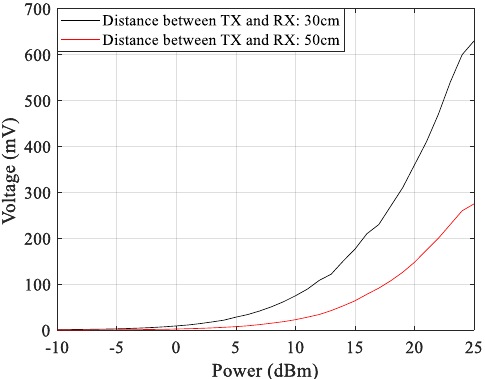
Figure 15. WPT system DC output power for two different distances and distinct transmitted powers.